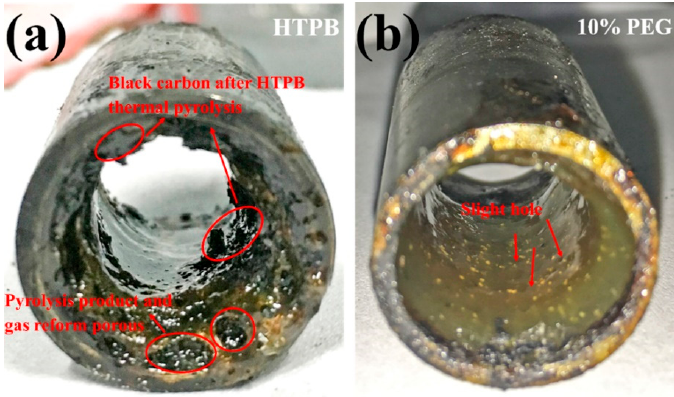
Figure 6. Images of ( a ) pure HTPB and ( b ) 10% PEG particles/HTPB composite fuel grains after terminating combustion.